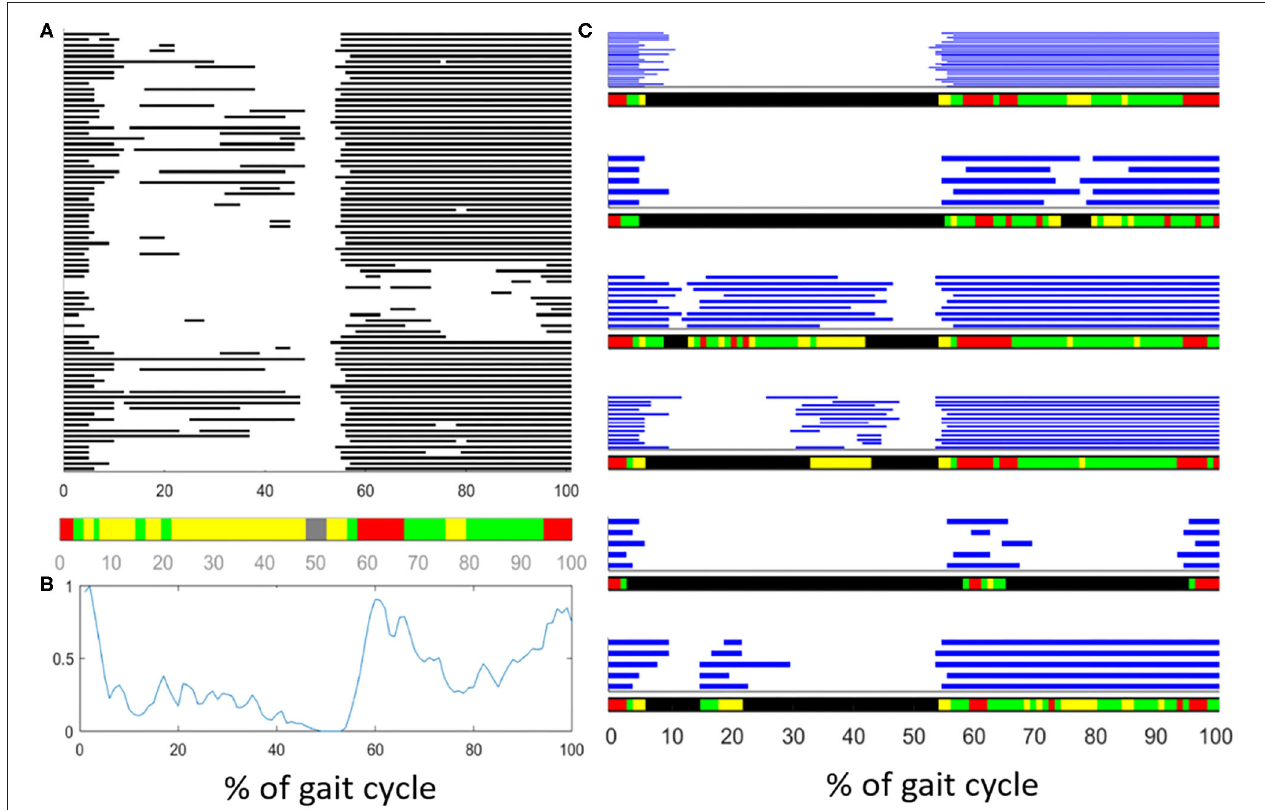
FIGURE 7 | Description of the effects of intrasubject variability on the interpretation of muscle activation patterns during gait. (A) Example of variability in the activationd of the Tibialis Anterior (TA) muscle of an healthy subject. Gray bars represent the activation intervals in different gait cycle of the same walk. Observing the average activity, represented in the color bar below (A) or represented as a “linear envelope” in (B) , one would conclude that TA muscle is almost always active. (C) After grouping together the gait cycles sharing the same activation-timing patterns, the average activation intervals (within each group) really represent the muscular activation patterns. In the latest case, the biomechanical task of each activation interval becomes clear.